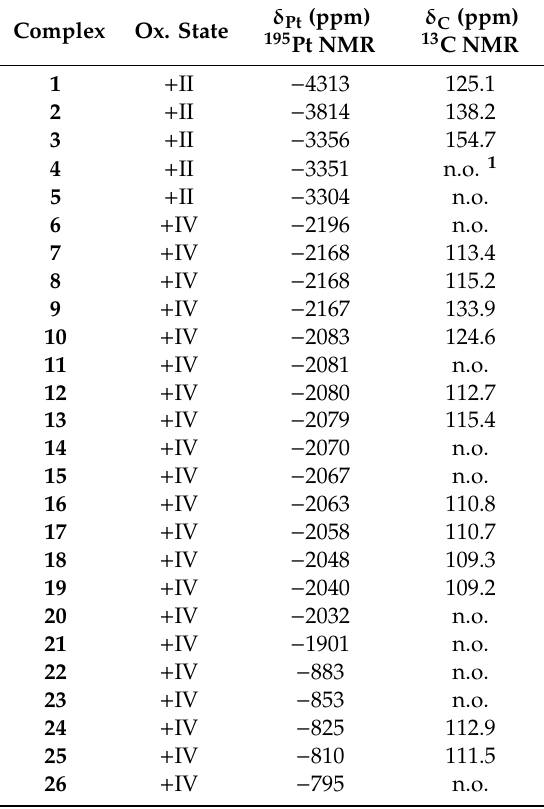
Table 2. Chemical shift evolution of the Pt signal as a function of the metal oxidation state, the coordination sphere of the metal and the NHC substituents (external reference for 195 Pt: H 2 PtCl 6 in D 2 O: δ Pt = 0